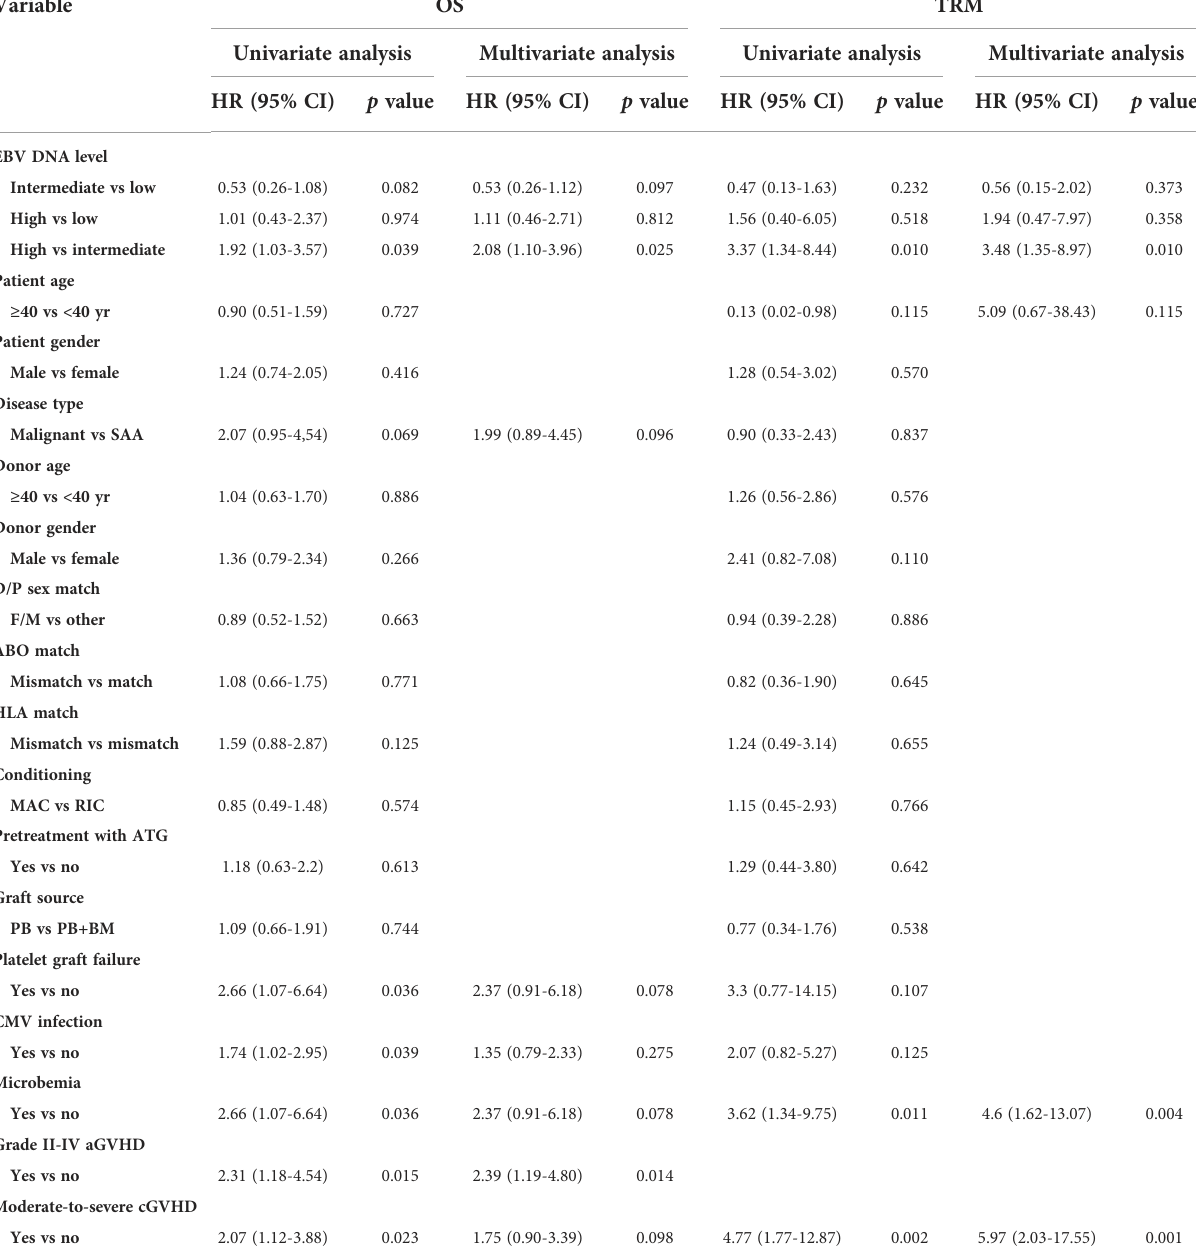
TABLE 4 Univariate and multivariate analyses for OS and TRM.